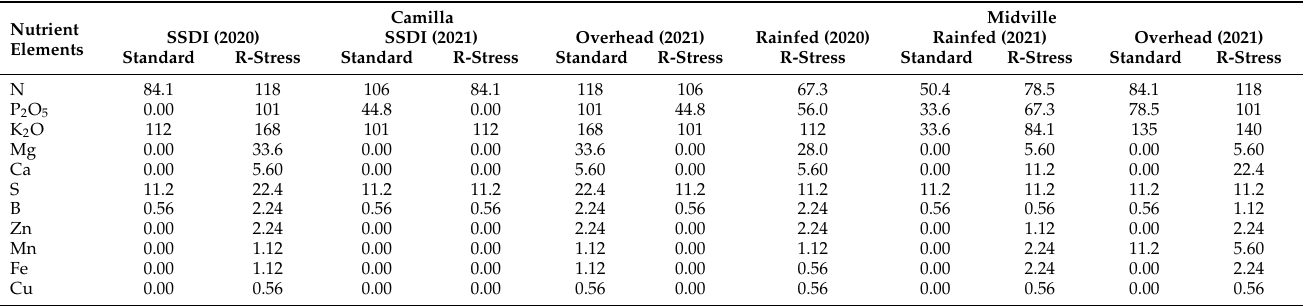
Table 1. Full nutrient application rates (in kg ha − 1 ) for the standard recommendation and reduced nutrient stress (R-stress) treatments imposed in Camilla and Midville, GA, under different production conditions.